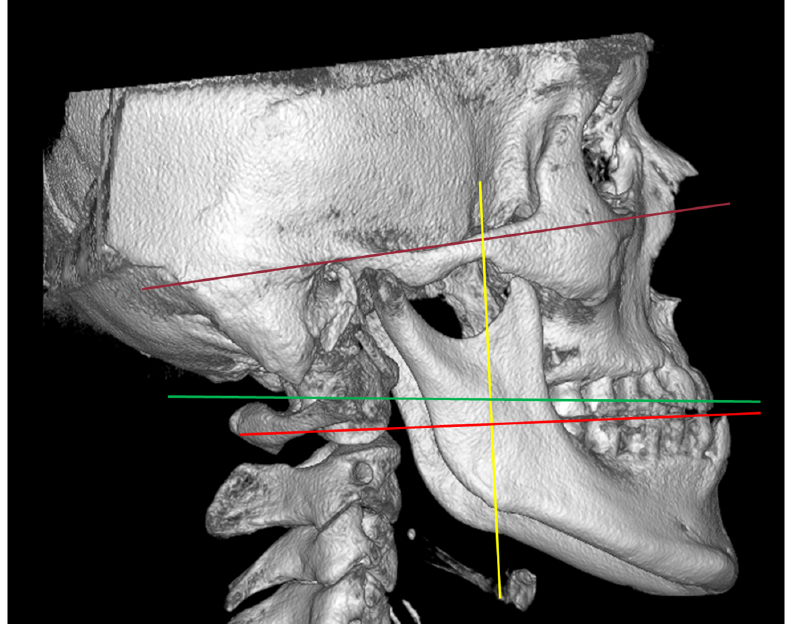
Figure 1. Reference lines: Brown line: Frankfort horizontal plane; Green line: axial plane of ramus; Red line: occlusal plane; Yellow line: vertical plane to occlusal plane.